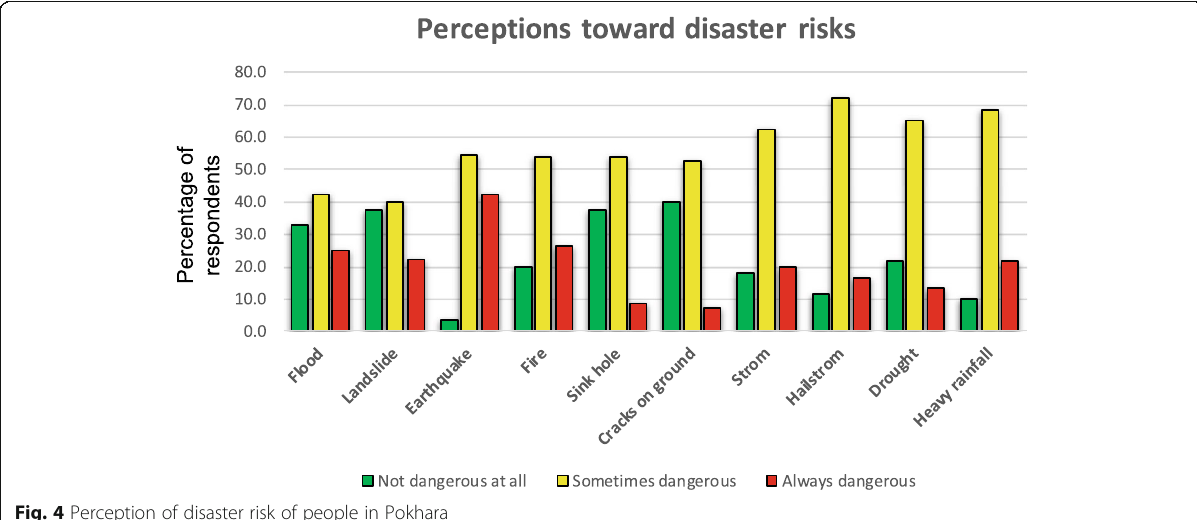
Fig. 4 Perception of disaster risk of people in